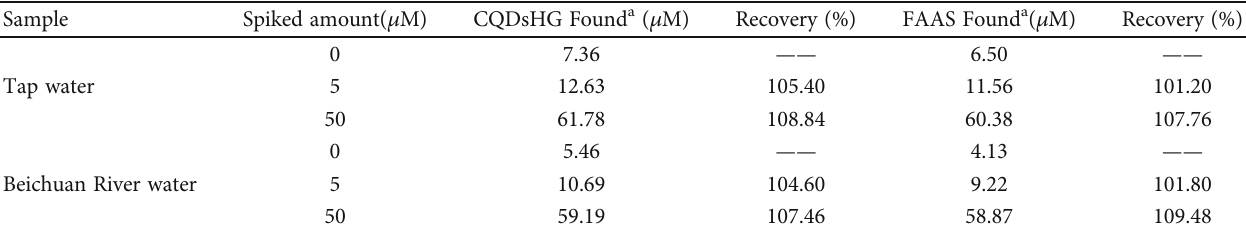
Table 3: Determination of Fe 3+ in real